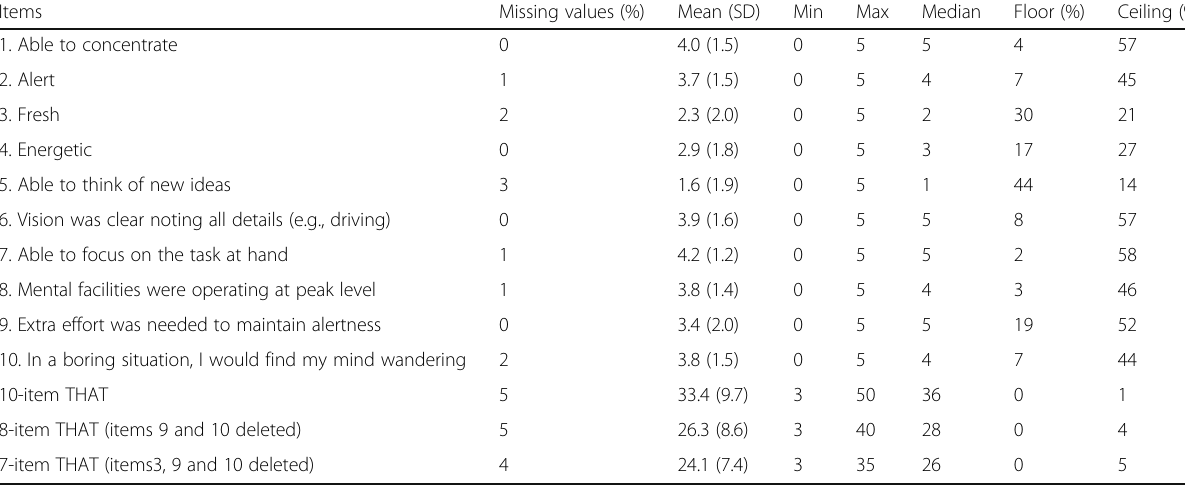
of the seven-item one-factor CFA model. Scale reliability and convergent validity The coefficient omega of the seven-item scale was